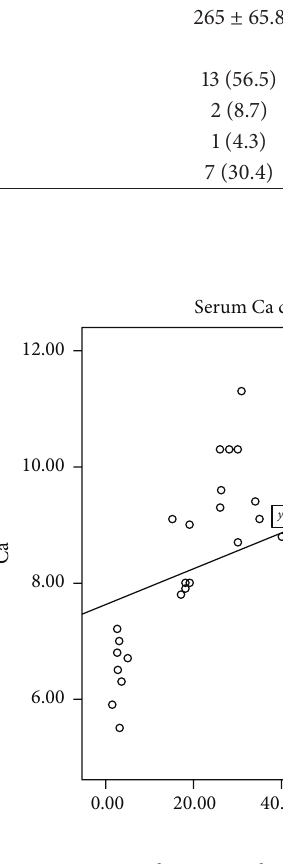
Figure 2: Serum calcium correlation to vitamin D. ∗ 𝑅 2 = 0.334, 𝑝 <